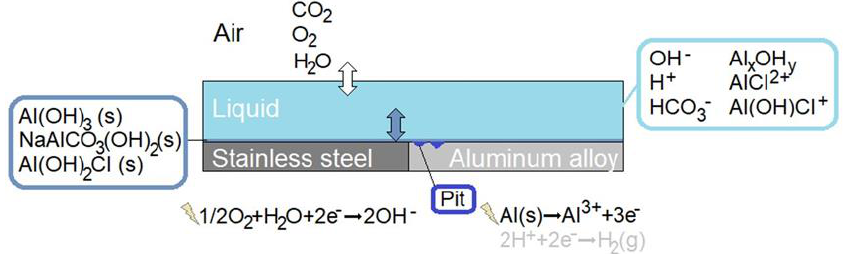
Figure 1. Schematic illustration of the bimetallic system forming the galvanic coupling that is simu- lated.